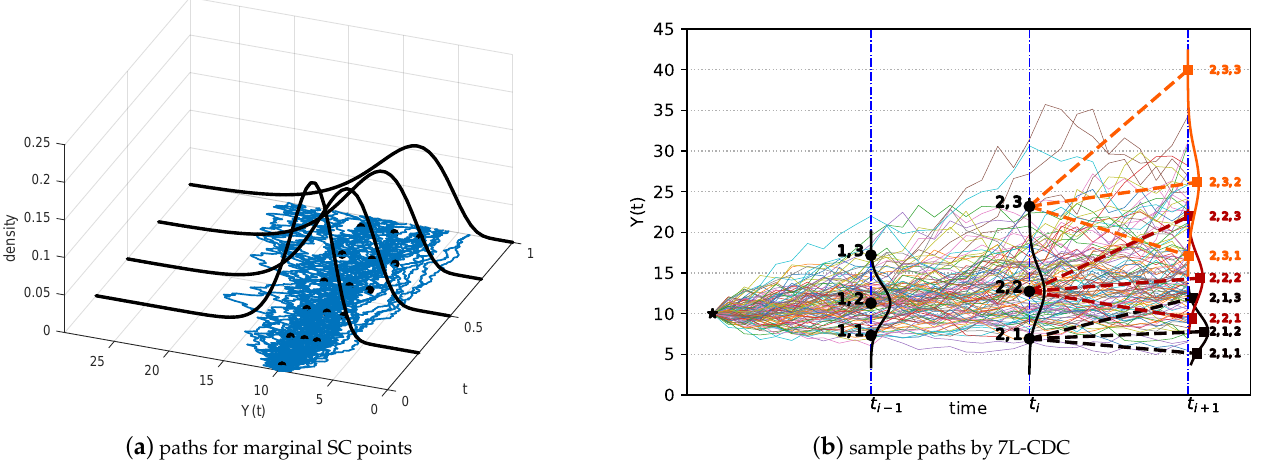
Figure 3. Schematic diagram of the 7L-CDC scheme at time t i . ( a ): marginal SC points, corresponding to Equation (29). ( b ): sample paths generated by 7L-CDC. The triple {2,1,3}, in the picture, represents the third conditional SC point, dependent on the first marginal SC point at time point t 2 . The above procedure is also applicable to other time